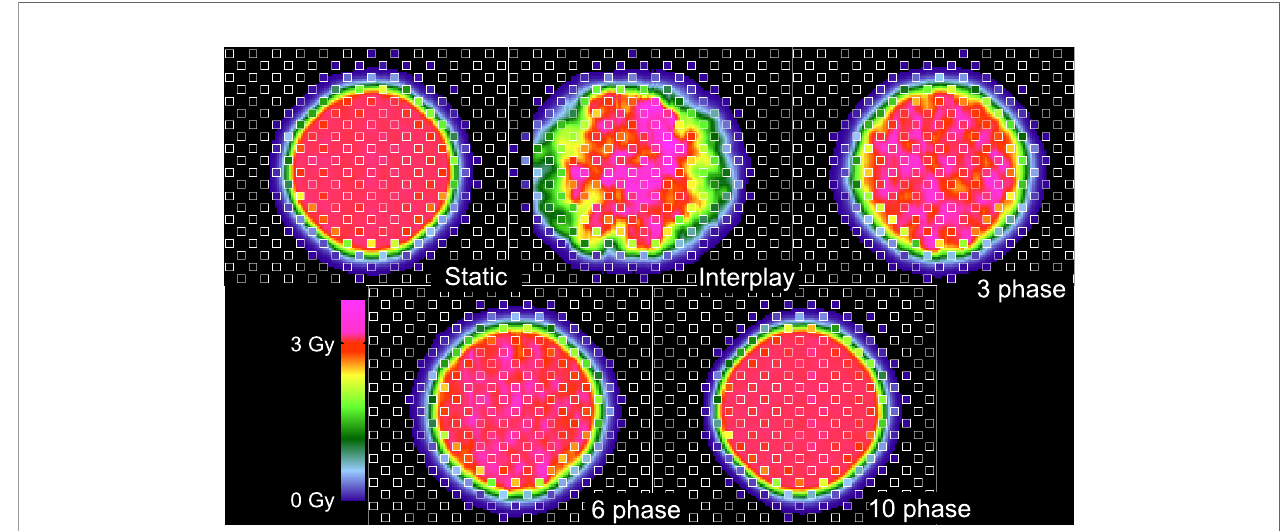
FIGURE 3 | Comparison of 2D ionization chamber array detector measurements to dose reconstructions. The bottom row shows measured absorbed dose values (values inside of small white squares) overlaid on reconstructed absorbed dose distributions (values outside of the small white squares). The dose distributions are distal to the density phantom (see Figure 1 ). Distributions are from four delivery techniques: static target, moving target without motion compensation (interplay), and moving target with multi-phase 4D motion compensation. Multi-phase 4D deliveries are shown using 3, 6, and 10 motion phases in the treatment plan